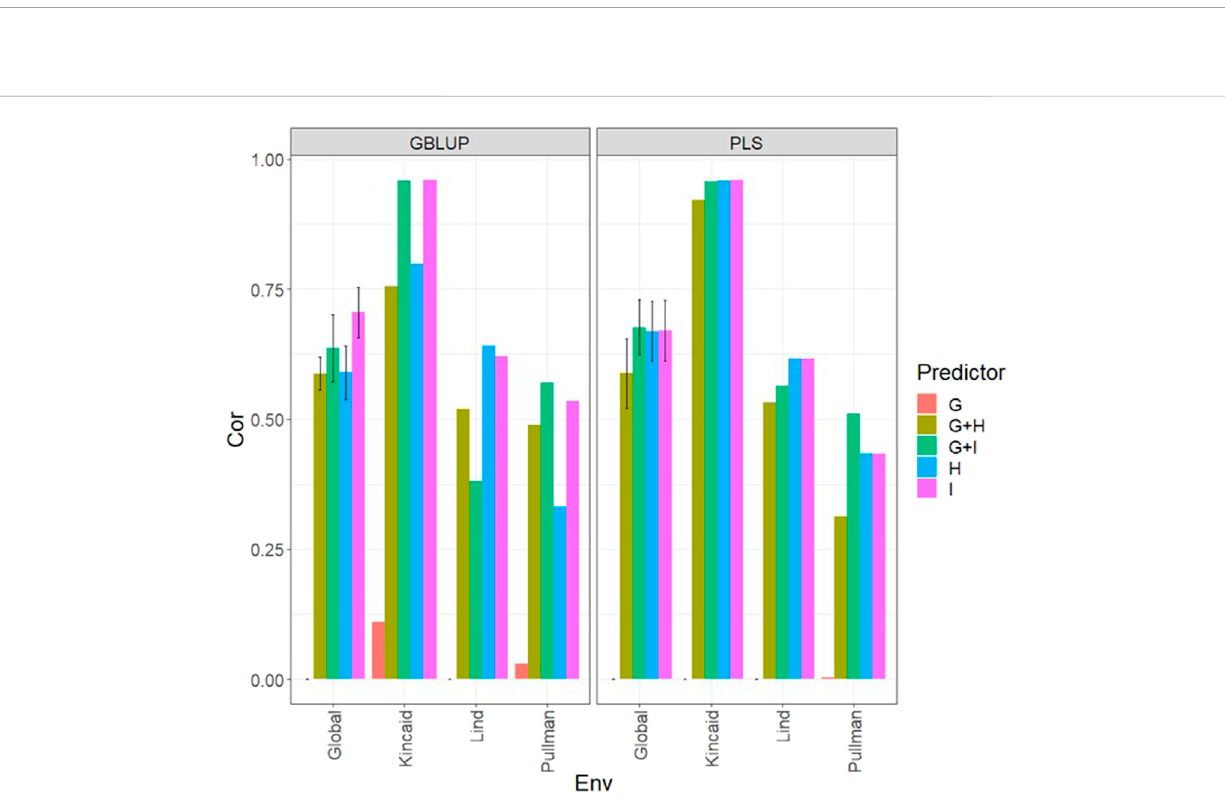
FIGURE 5 Dataset 1 (year 2019). Pearson´s correlation (Cor) and their corresponding Standard Error (SE) for each location and across location (Global) under tested lines in untested environments (LOEO) for nine evaluated predictors under a GBLUP and PLS